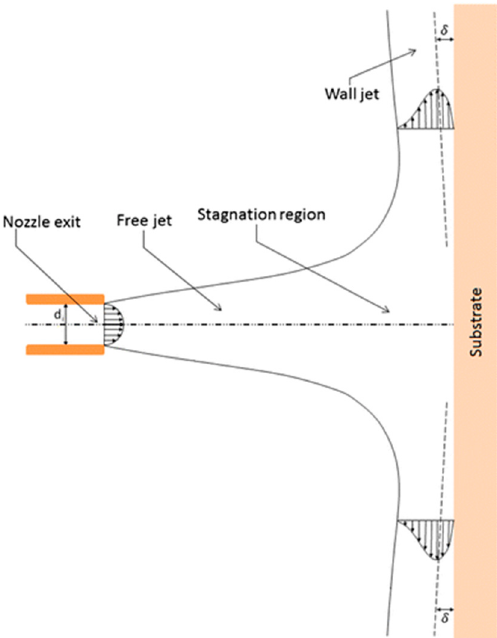
Figure 2. Schematic of a typical impinging gas-jet system [8].